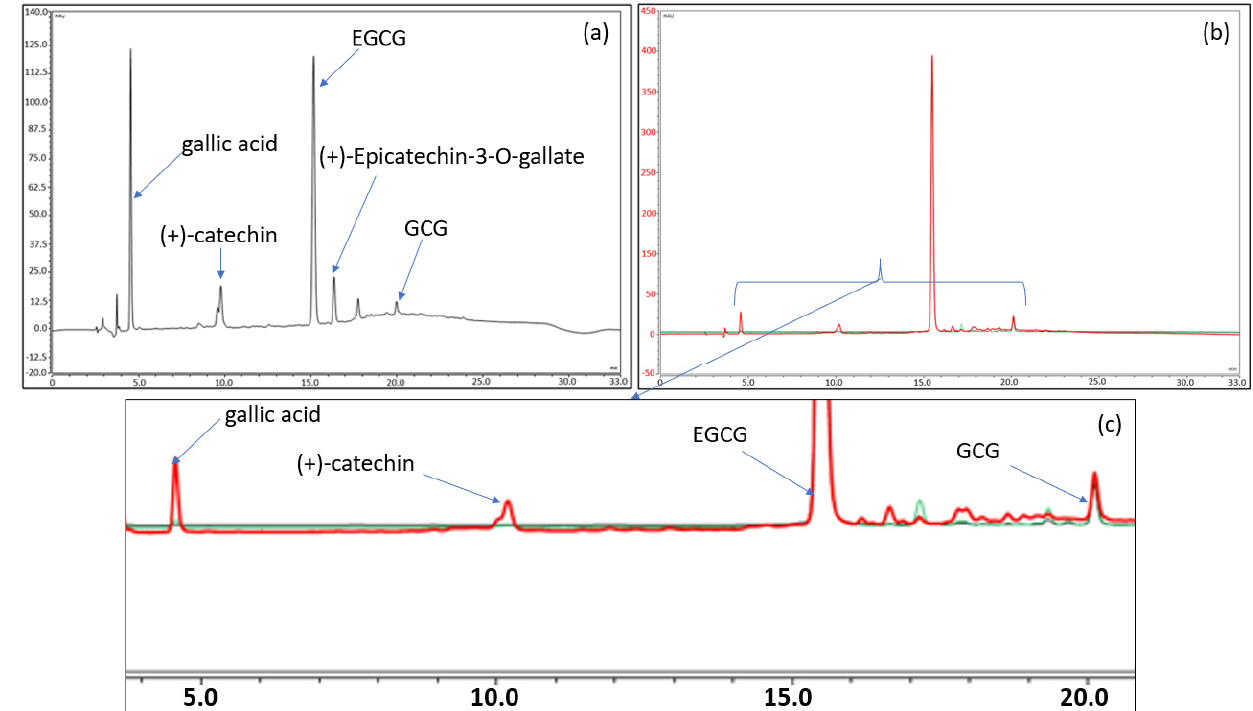
Figure 7. ( a ) Chromatogram of the EGCG formulation stored for 17 days at 80 ◦ C. ( b , c ) Total and enlarged chromatogram of the EGCG formulation stored 6 months at 4 ◦ C (in black), at 25 ◦ C (in green), and at 40 ◦ C (in red). The chromatograms have been normalized on the EGCG peak to compare the chromatographic profiles. The chromatograms of 6 months at 4 ◦ C (in black) and at 25 ◦ C (in green) are almost indistinguishable from each other as the drug products contain similar amounts of degradation products.